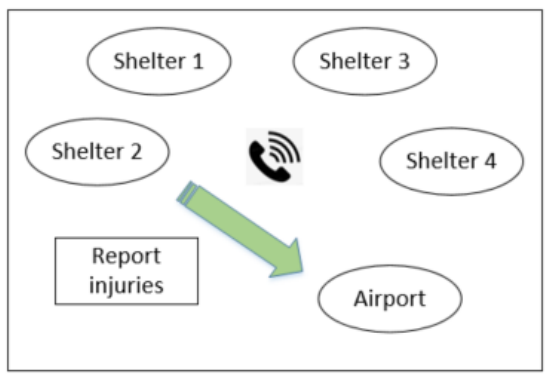
Figure 5. Information flow in Level two.